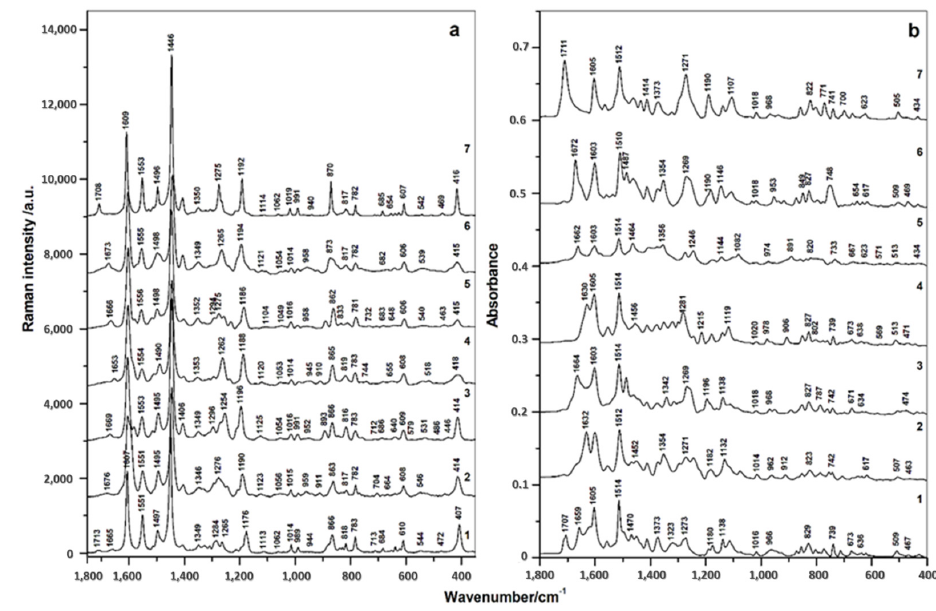
Figure 2. Raman ( a ) and FTIR ( b ) spectra of compounds 1 – 7 .